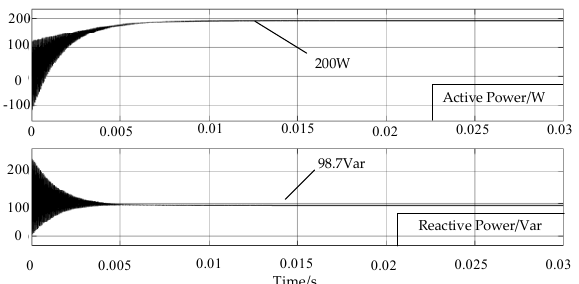
Figure 24. φ AD = 97.2° and φ AB = 115° active power and reactive power waveforms. The selected phase-shift angles ( φ AD = 31°, φ AB = 80.2°) for the comparison of reactive power values is shown in Figure 25.